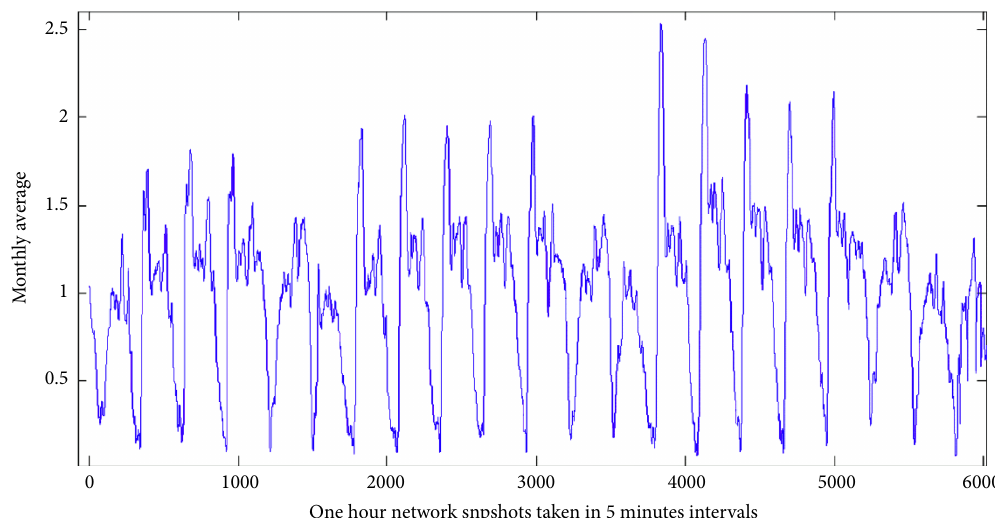
Figure 7: Dynamics of the potential ride-sharing utilization over time. X -axis denotes the time, given in 5-minute granularity. Y -axis denotes the change of the potential utilization compared to its monthly average.